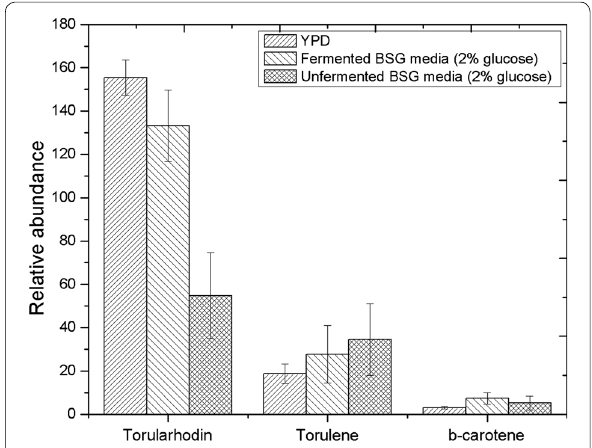
Fig. 3 Relative production of carotenoids; torularhodin, torulene and β-carotene, by R. toruloides when grown in YPD, fermented BSG (2% w/w glucose) and unfermented BSG (2% w/w glucose) media at the end of 5-days